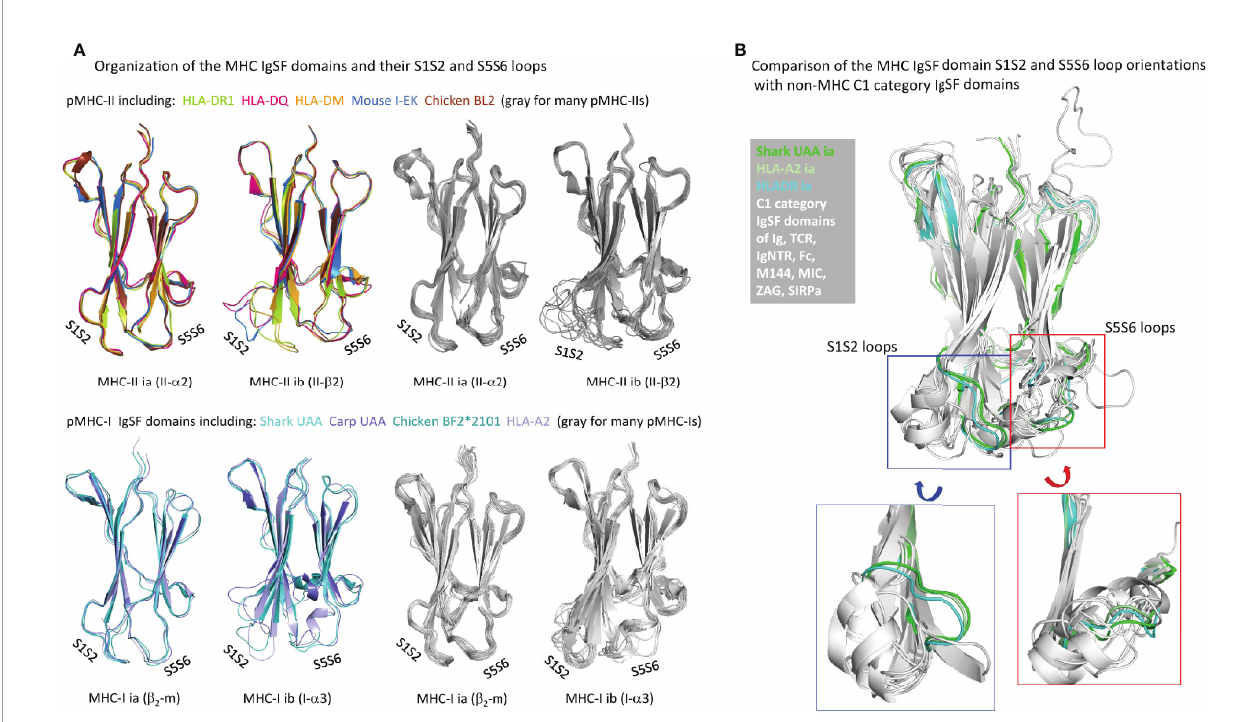
FIGURE 10 | Organization of MHC IgSF domain S1S2 and S5S6 loops. (A) Superpositions of representative pMHC-II and pMHC-I IgSF domains (left part of the fi gure) and many pMHC-II and pMHC-I IgSF domains (all colored in gray; right part of the fi gure) show that the MHC IgSF consensus orientation of the S1S2 and S5S6 orientations are well conserved in the pMHC-II and pMHC-I ia domains; (B) if representative MHC IgSF domains possessing this organization are compared with a variety of non-MHC IgSF C1 set domains, it can be seen that especially their S1S2-loop orientation is quite